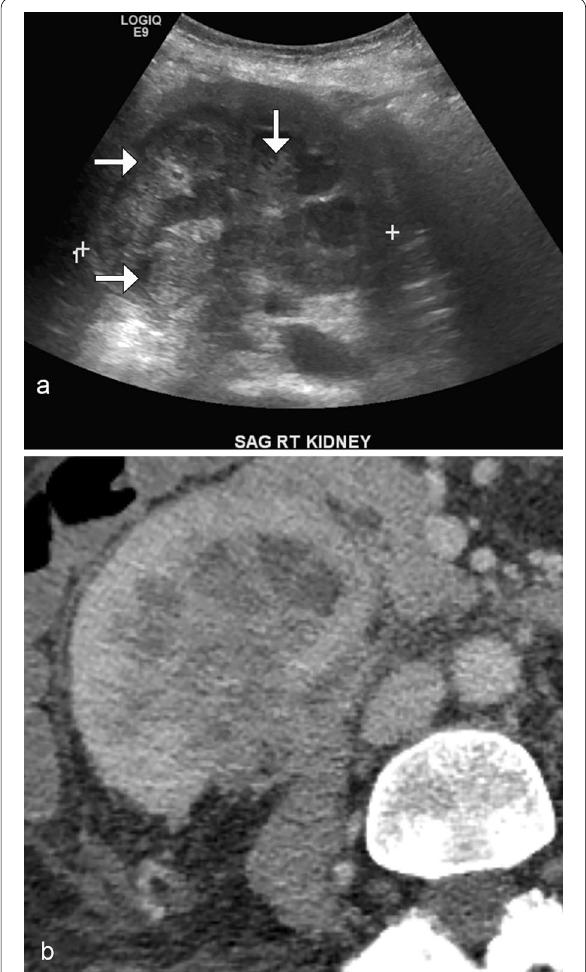
Fig. 15 Urothelial carcinoma. Sagittal grayscale ultrasound ( a ) demonstrates an enlarged right kidney with relative preservation of the reniform shape. Note the diffuse infiltration of the pelvocalyceal system (arrows). Contrast-enhanced axial CT ( b ) shows the diffuse enlargement of the right kidney with infiltrative tissue centered in the collecting system; subsequent biopsy confirmed urothelial carcinoma, mimicking the diffuse infiltration/nephromegaly pattern of renal